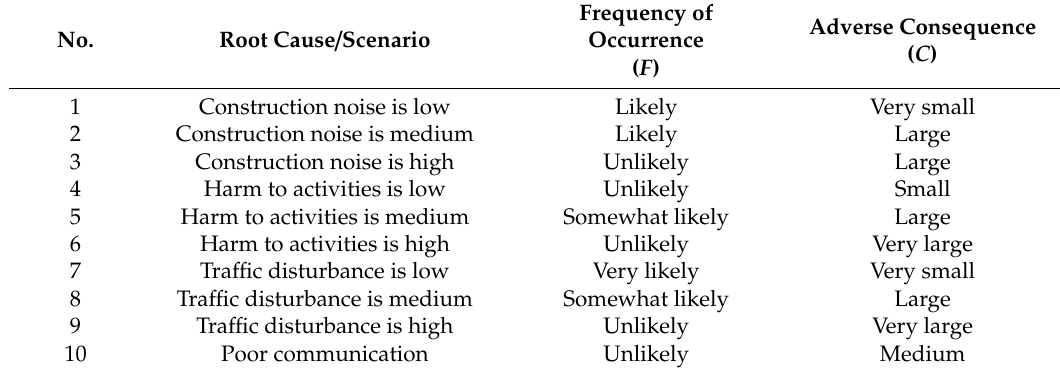
Table 1. Root causes of risk factors with accompanying scenarios and assessment.